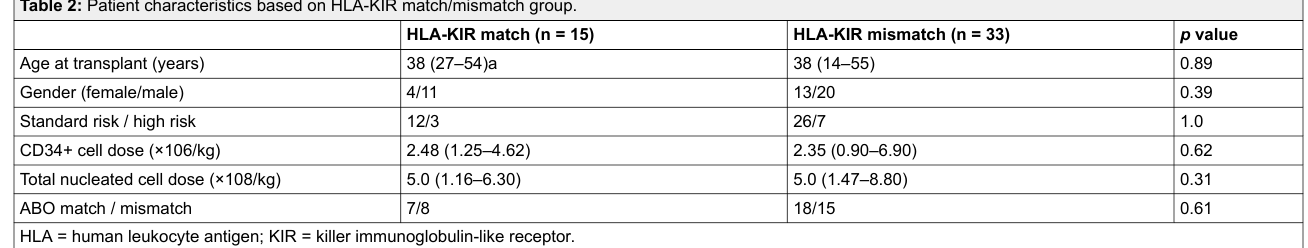
Table 2: Patient characteristics based on HLA-KIR match/mismatch group.